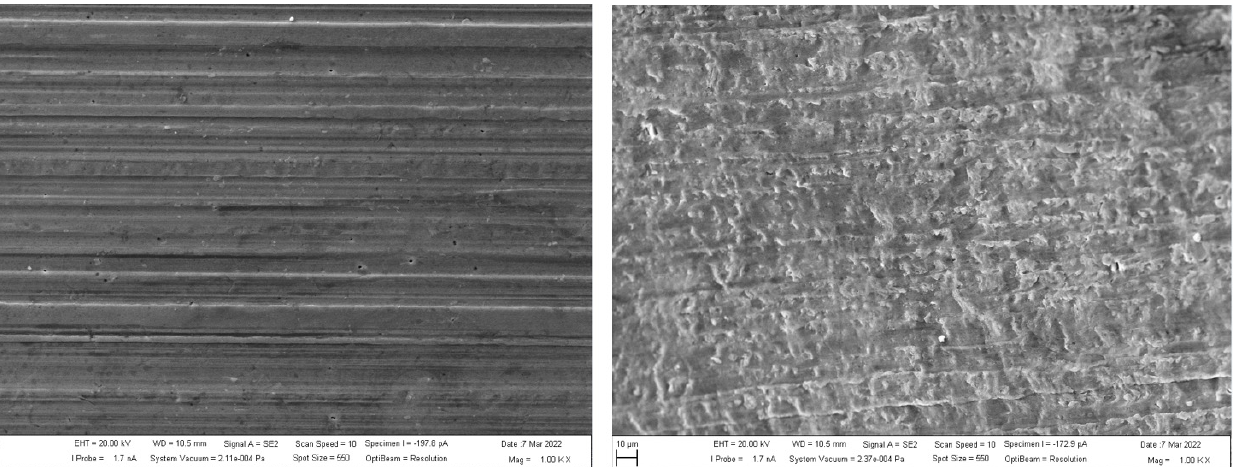
Figure 11. SEM analysis of Al-Al joint, element maps, EDS spectra, and fracture surfaces of bush- ing. The yellow border contains a detailed view on the top surface of the lower material. The red border contains a detailed view on the bottom surface of the upper material.